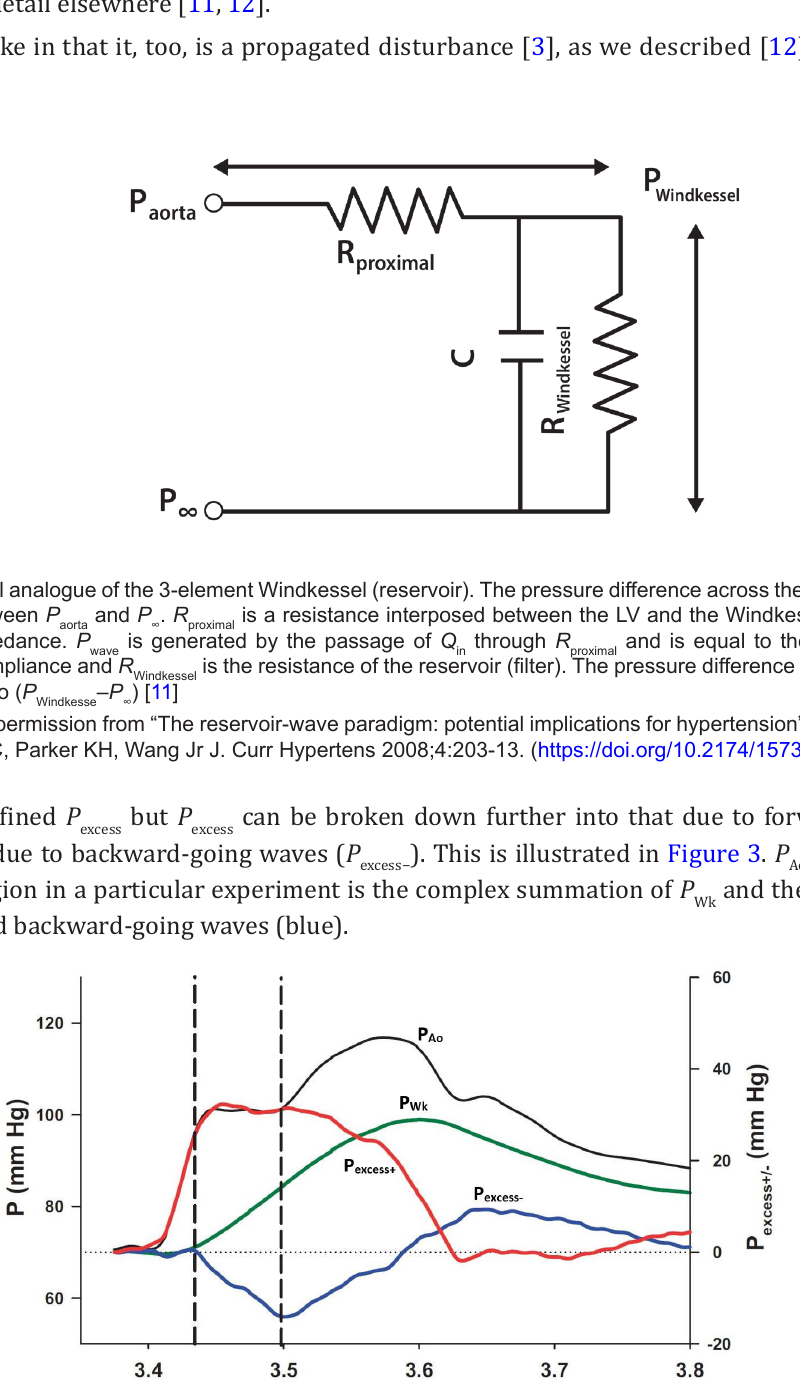
Figure 3. The interaction of each of the pressure components at the diaphragm. P scale on the left) were plotted together with P in measured pressure is delimited by the vertical dashed lines during which interval the increase in P decrease in P excess−